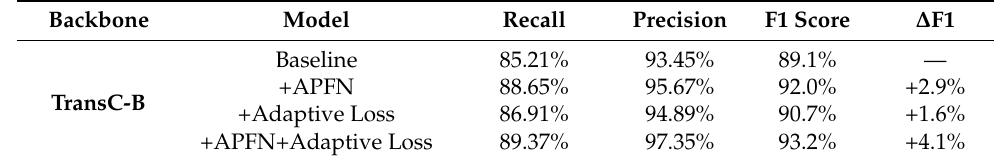
Table 4. Results of ablation study. Experiment was implemented on VEDAI data